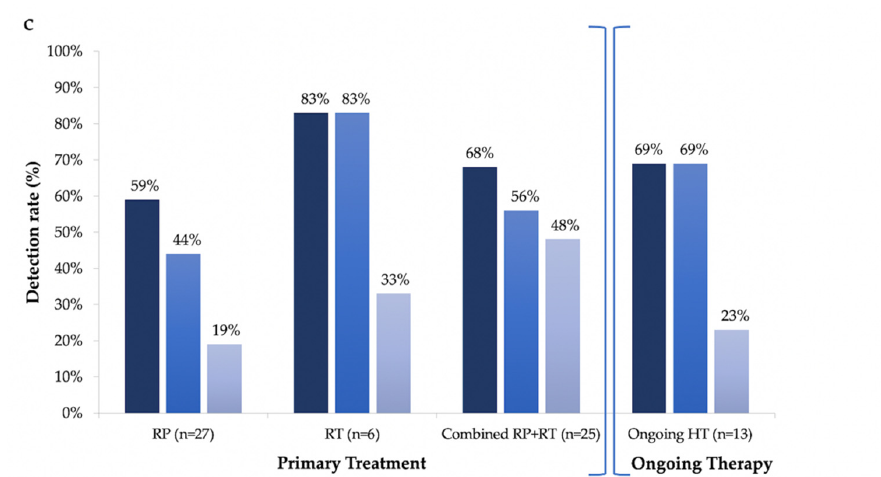
Figure 2. ( a ) Per-patient and per-lesion detection rate of [ 18 F]Fluciclovine PET/CT in relation to ( a ) PSA value and PSA doubling time, ( b ) Gleason Score (GS) and European Association of Urology (EAU) biochemical recurrence (BCR) risk groups, and ( c ) primary treatments, including prostatectomy alone (RP), radiotherapy alone (RT) or combined (RP + RT), and ongoing hormonal therapy (HT). ROC analysis showed a PSA value of 0.45 ng/mL as the optimal cut-off value for predicting positive [ 18 F]Fluciclovine PET/CT scan (sensitivity 92%; specificity 55%), with